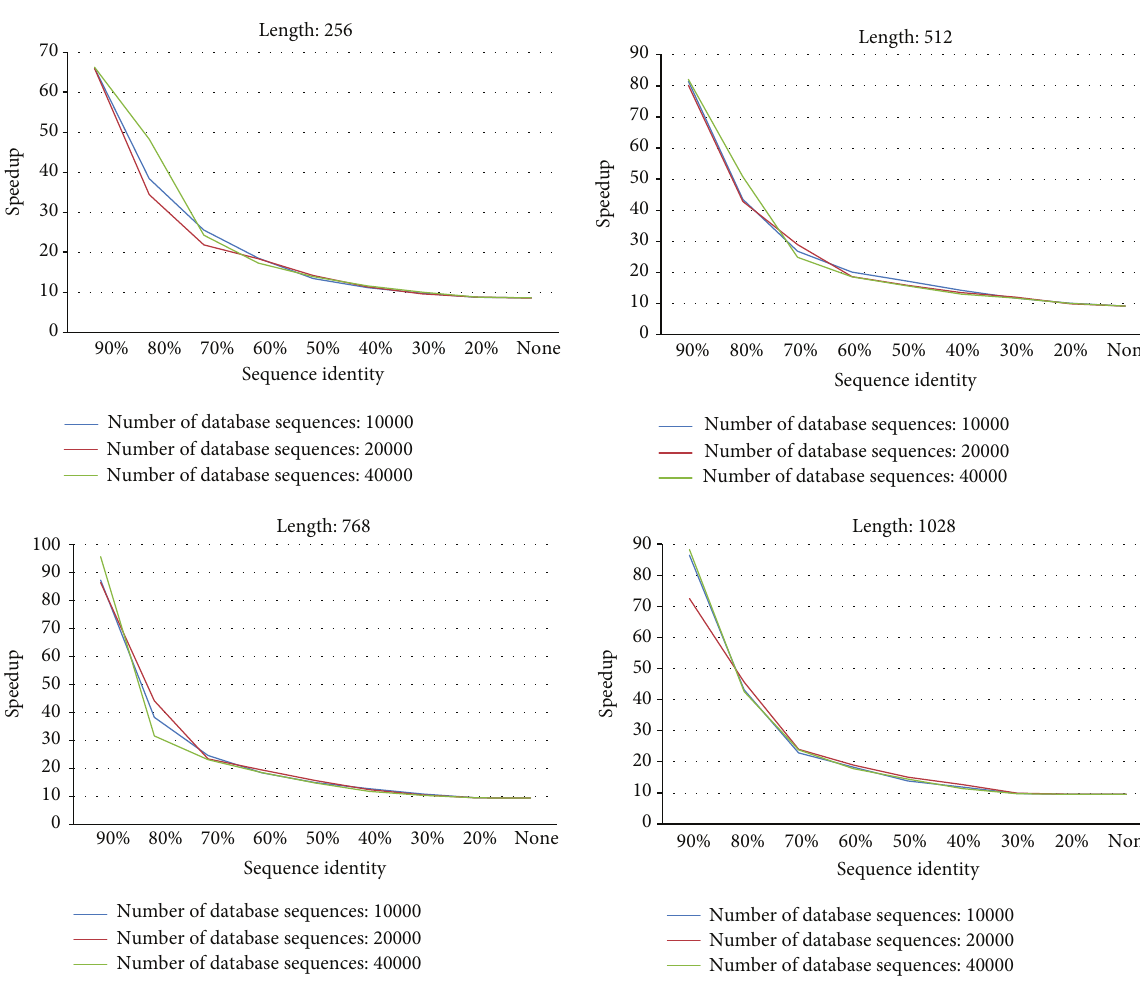
Figure 5: The overall speedup by comparing CUDA-SWfr with the CPU-based SW method under various thresholds for 12 synthetic